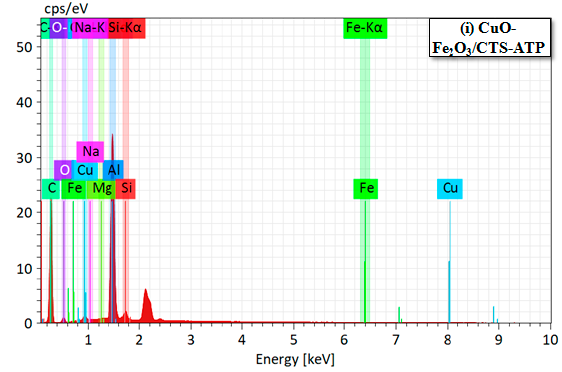
Figure 2. SEM ( a – d ); Mapping ( e , f ); and EDS ( g – i ) images of the samples.